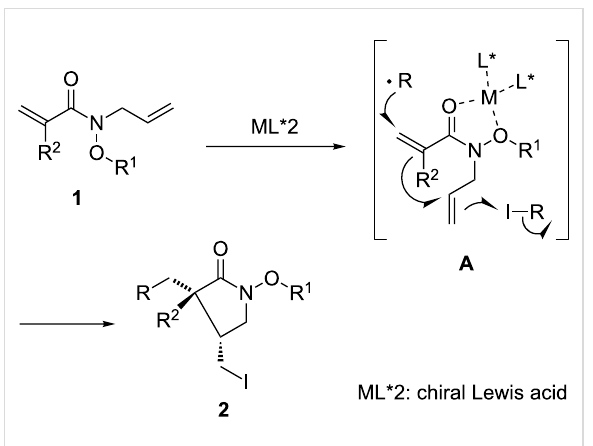
Figure 2: Our method for controlling the geometry of substrates and the stereochemistry of